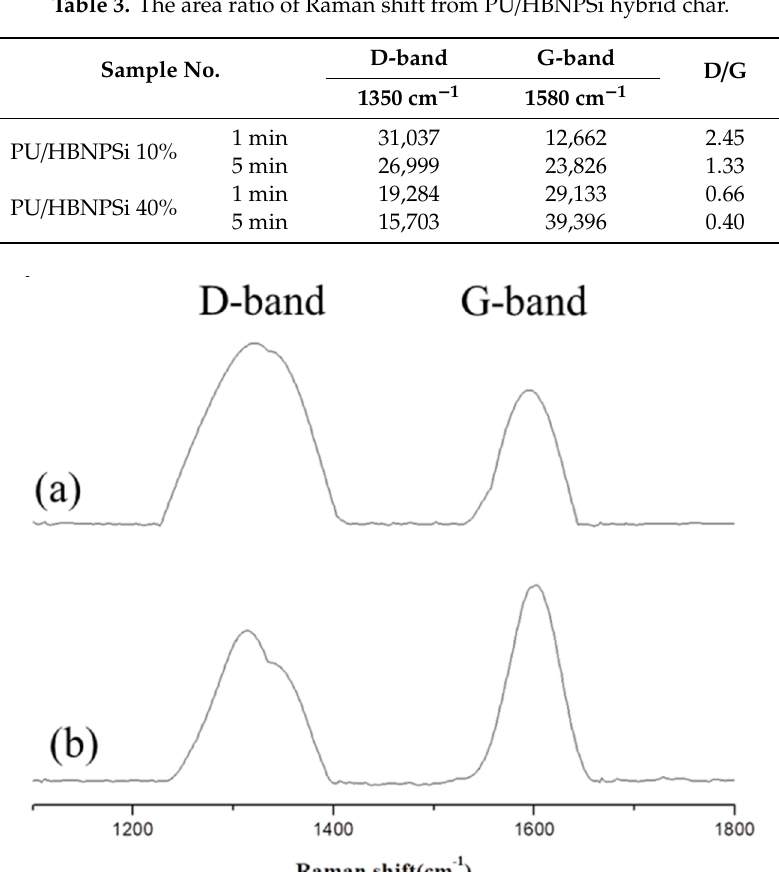
Figure 10. The Raman spectra of char products from PU/HBNPSi 10% at 800 °C ( a ) 1 min and ( b ) 5 min.